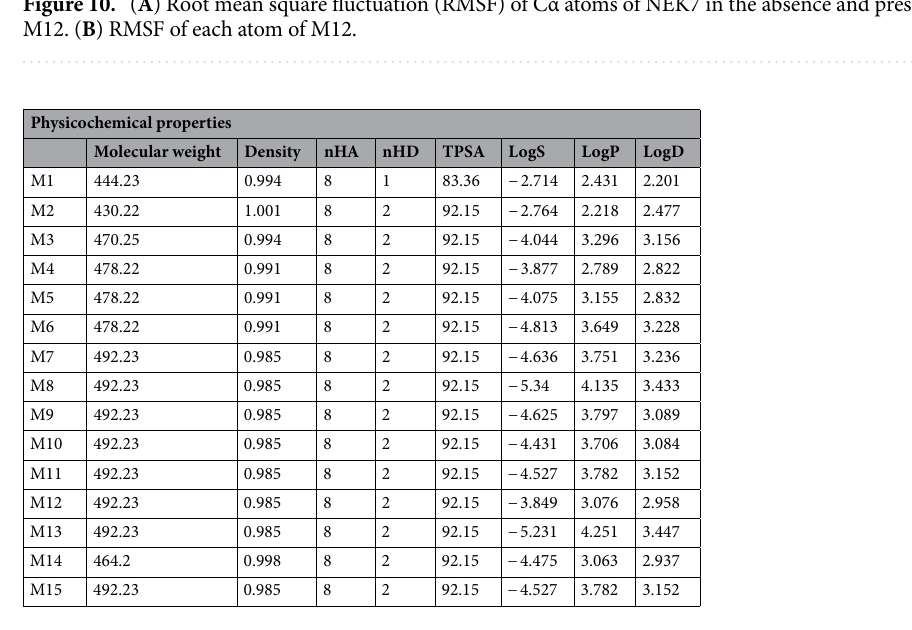
Table 4. Physicochemical properties of compounds.